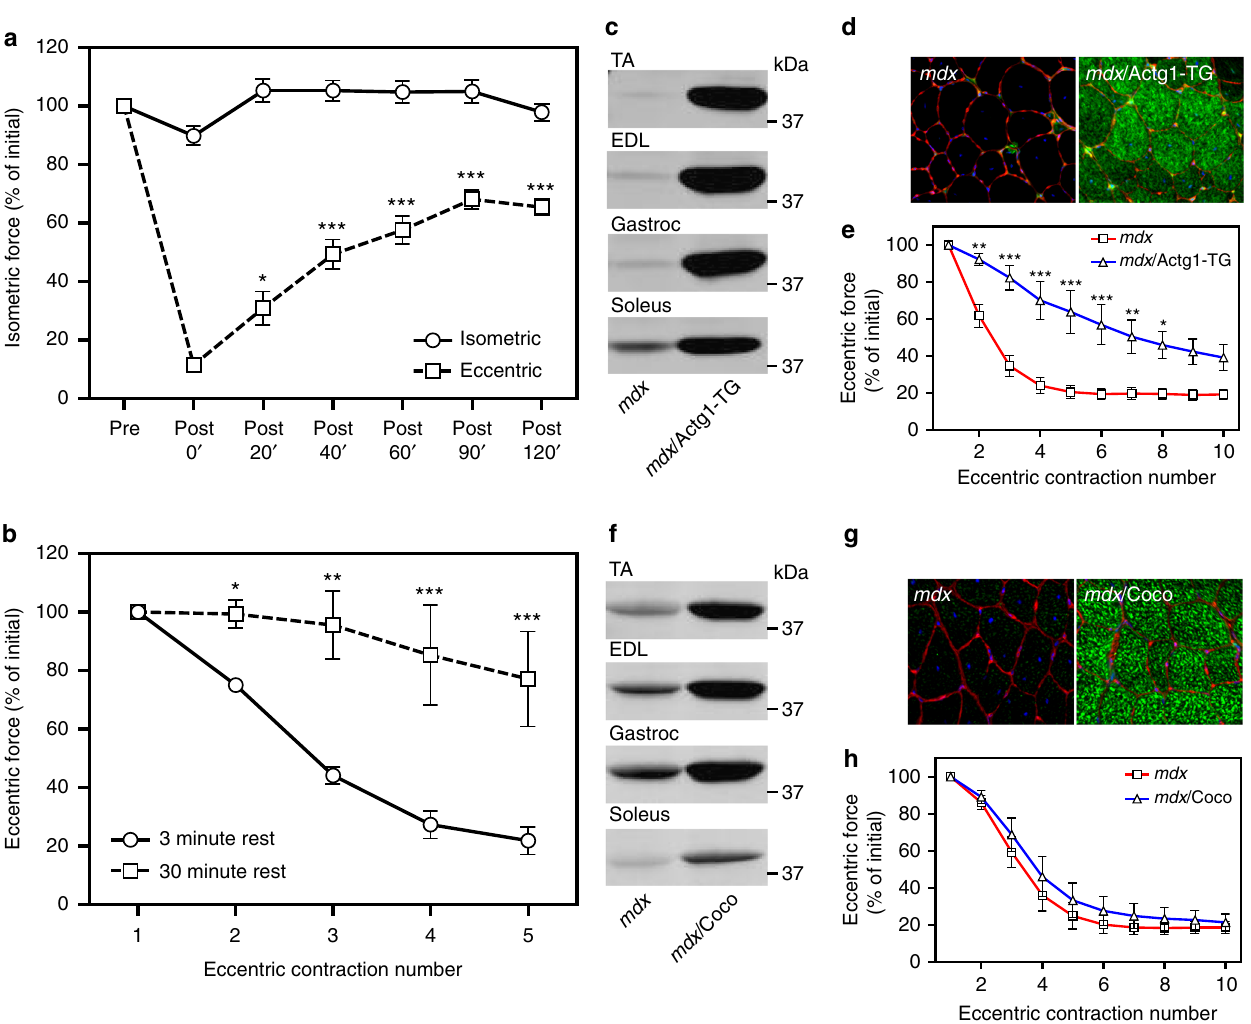
Fig. 1 Eccentric contraction-induced force loss in mdx muscle recovers rapidly and is partially protected by overexpression of γ cyto -actin, but not α cardiac - actin. a Recovery of isometric force production in isolated extensor digitorum longus (EDL) muscles from mdx mice subjected to 10 maximal isometric or eccentric contractions. Values are expressed as a percentage of the isometric force measured before the 10 contractions (Pre) for each timepoint listed; n = 4 for both conditions. * P < 0.05, *** P < 0.001 compared with Post 0 ’ ; two-way ANOVA. b Increasing the time interval between eccentric contractions from 3 to 30 min signi fi cantly diminishes the measured force loss in EDL muscles from mdx mice; n = 4 for both conditions. * P < 0.05, ** P < 0.01, *** P < 0.001 compared to 3 min Rest; two-way ANOVA. c Immunoblot analysis of γ cyto -actin in tibialis anterior (TA), extensor digitorum longus (EDL), gastrocnemius (Gastroc), and soleus muscles from mdx /Actg1-TG mice versus non-transgenic mdx littermates. d Immuno fl uorescence analysis of γ cyto - actin (green), laminin (red), and DAPI (blue) in 10 µ m cryosections of quadriceps muscle from mdx /Actg1-TG mice versus non-transgenic mdx littermates. e EDL muscles isolated from mdx /Actg1-TG mice and non-transgenic mdx littermates were subjected to 10 eccentric contractions and the force measured at each contraction expressed as a percentage of the force produced during the fi rst contraction; n = 4 for both genotypes. * P < 0.05, ** P < 0.01, *** P < 0.001 compared to mdx ; two-way ANOVA. f Immunoblot analysis of α ca -actin in tibialis anterior (TA), extensor digitorum longus (EDL), gastrocnemius (Gastroc), and soleus muscles from mdx /Coco mice versus non-transgenic mdx littermates. g Immuno fl uorescence analysis of α ca -actin (green), laminin (red), and DAPI (blue) in 10 µ m cryosections of quadriceps muscle from mdx /Coco mice versus non-transgenic mdx littermates. h EDL muscles isolated from mdx /Coco mice and non-transgenic mdx littermates were subjected to 10 eccentric contractions and the force measured at each contraction expressed as a percentage of the force produced during the fi rst contraction; n = 4 for both genotypes. Throughout, error bars represent means ±